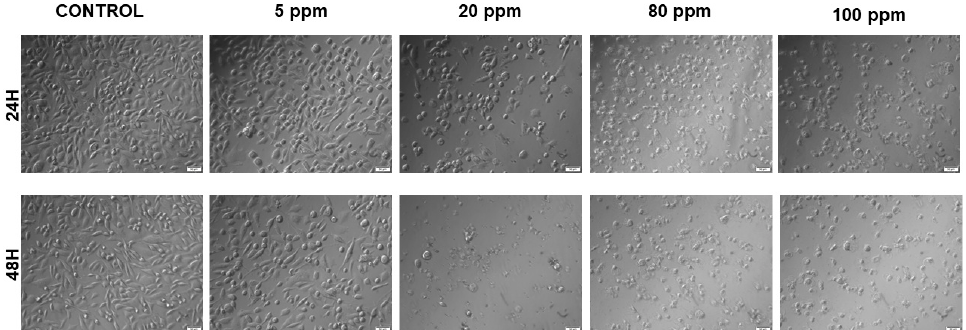
Figure 3. Bright field microscopy images of PC-3 cell morphology after exposure to different concentrations of AgNPs ranging from 5 to 100 ppm, for 24 h and 48 h (20× OLYMPUS IX51 microscope).